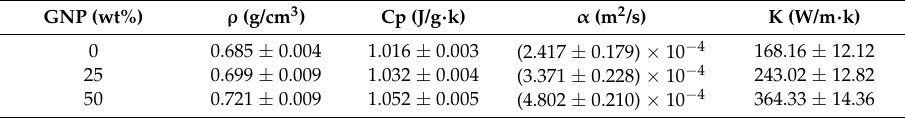
Table 1. Thermal properties of the hybrid films with the different weight percentages of GNP. GNP